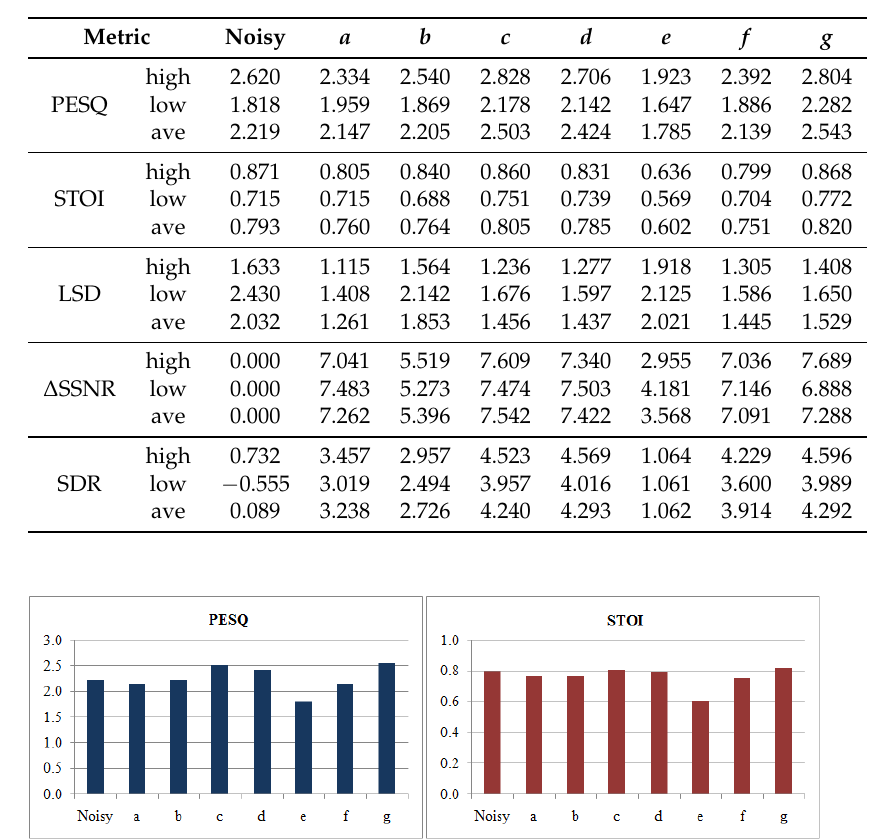
Table 3. PESQ, STOI, LSD, and, ∆ SSNR results at high SNR levels: 20 dB, 15 dB, and 10 dB; low SNR levels: − 5 dB, 0 dB, 5 dB; and, the average of high and low SNRs (ave).